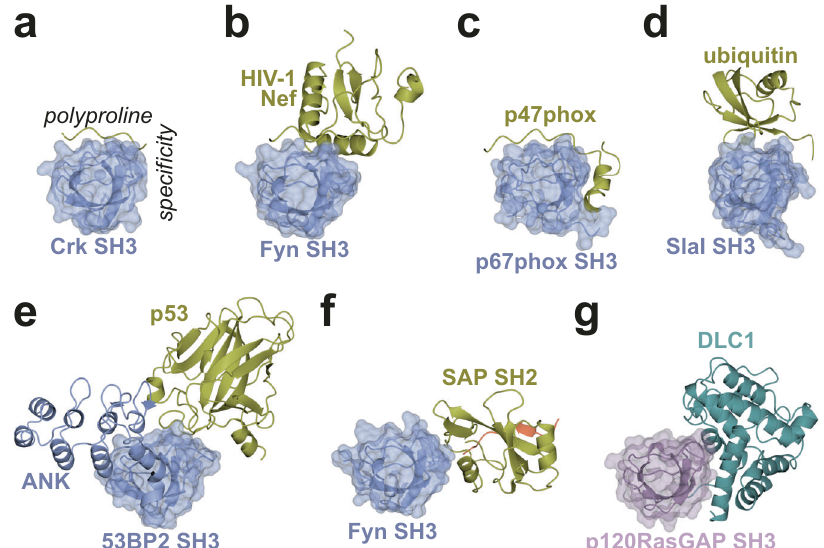
Fig. 7 | Comparison of atypical SH3 binding partners. Examples of atypical SH3 domain complexesthatbind partnerproteins outsideofthe canonicalpolyproline site. In all panels, the SH3 domain (shown as light blue ribbon and partially trans- parent surface in ( a ) thru( f ) orientation and scale is identical, with the polyproline site on top and the speci fi city pocket is on the right hand side as labeled in ( a ). All binding partners in panels ( a ) thru ( f ) are shown as ribbon diagrams and colored gold. a Crk/peptide (to illustrate canonical binding; PDB ID: 1CKA 70 ). b Fyn SH3